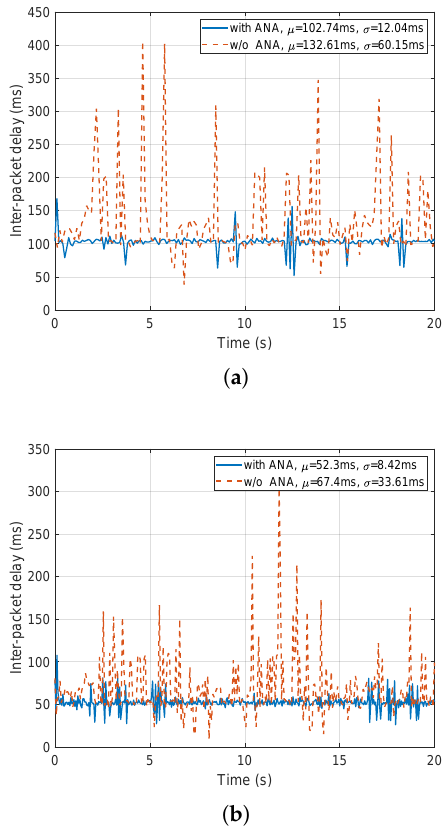
Figure 11. Performance of two simultaneously running UDP applications that require transmission delay less than ( a ) 100ms (i.e., inter-packet delay < 200ms) and ( b ) 50ms (i.e., inter-packet delay < 100ms) from a saturated IEEE 802.11g